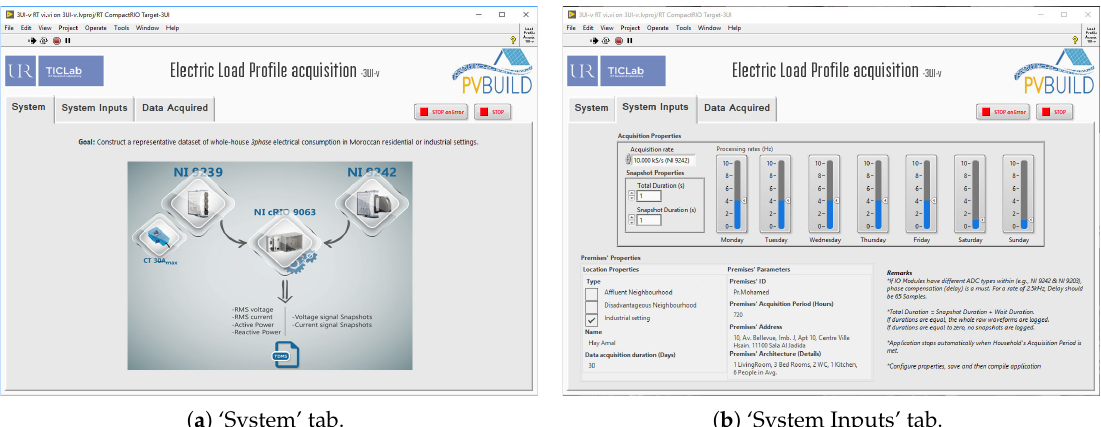
Figure 6. User interface of the three-phase electric load profile acquisition